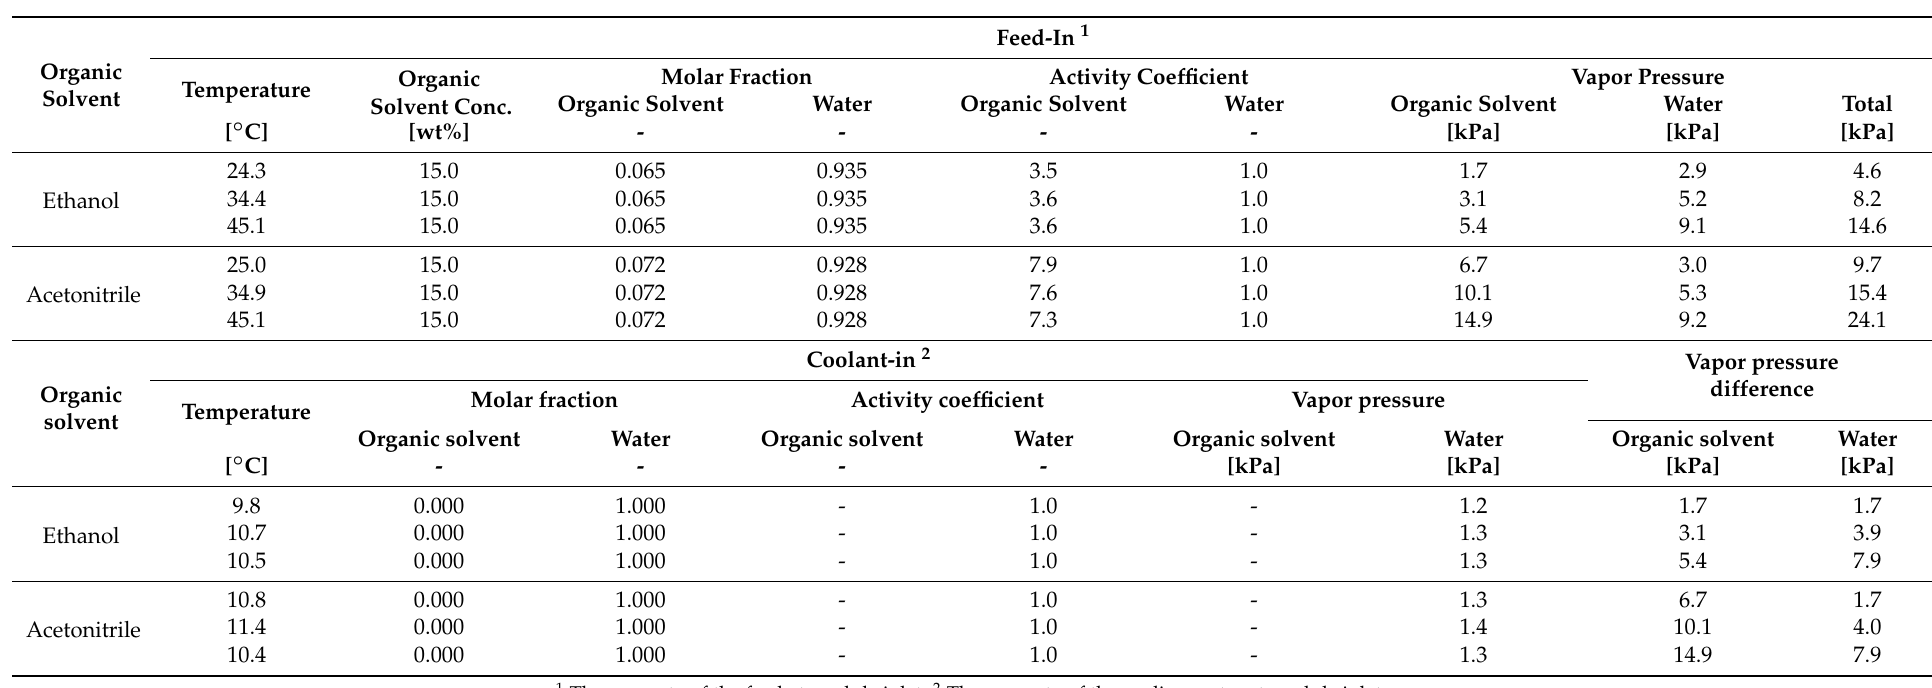
Table 6. The activity coefficient, vapor pressure of organic solvent and water, calculated from the operating condition of feed-in temperature and coolant-in temperature of the module, and